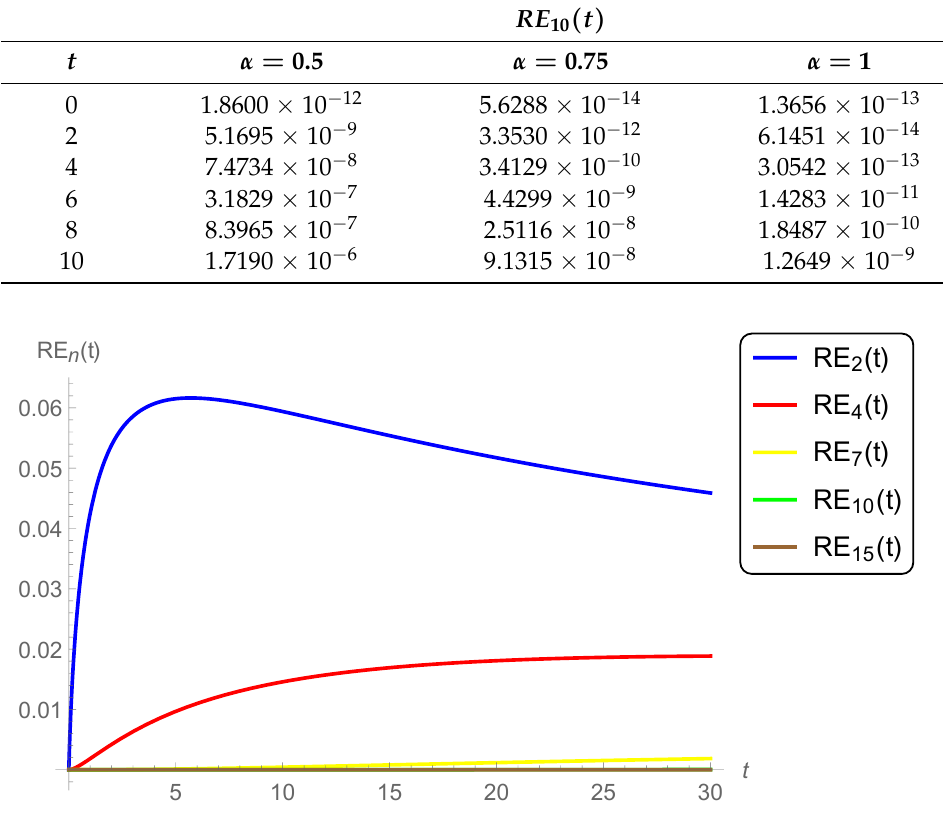
Figure 2. Graphs of the n -th errors RE n ( t ) with n = 2,4,7,10,15 and λ = 1, q = 1.5, and α =